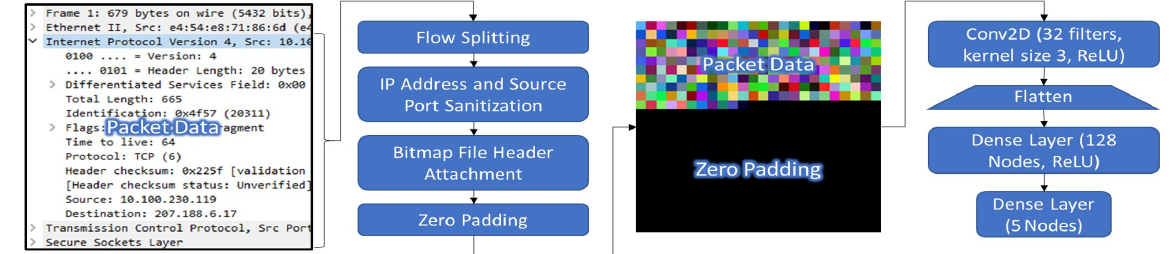
Figure 1. The full data pipeline for our analysis. The first half show preprocessing done on PCAP (network traffic) files to produce separate BMP (bitmap image) files for each flow. IP addresses in each bidirectional flow are randomized to create the effect of multiple attack sources. The IP datagrams from each flow are extracted and appended as-is to a predefined BMP file header. The